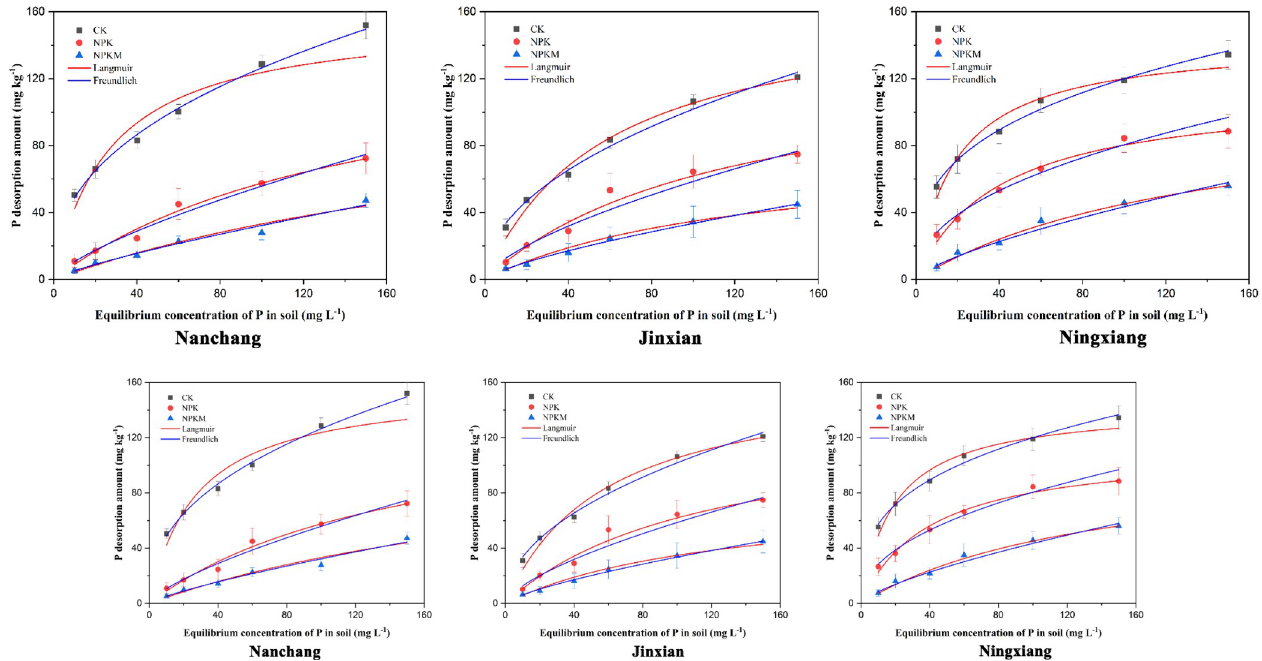
Fig 2. Desorption isotherms of P in red paddy soils at three different long-term experimental sites.